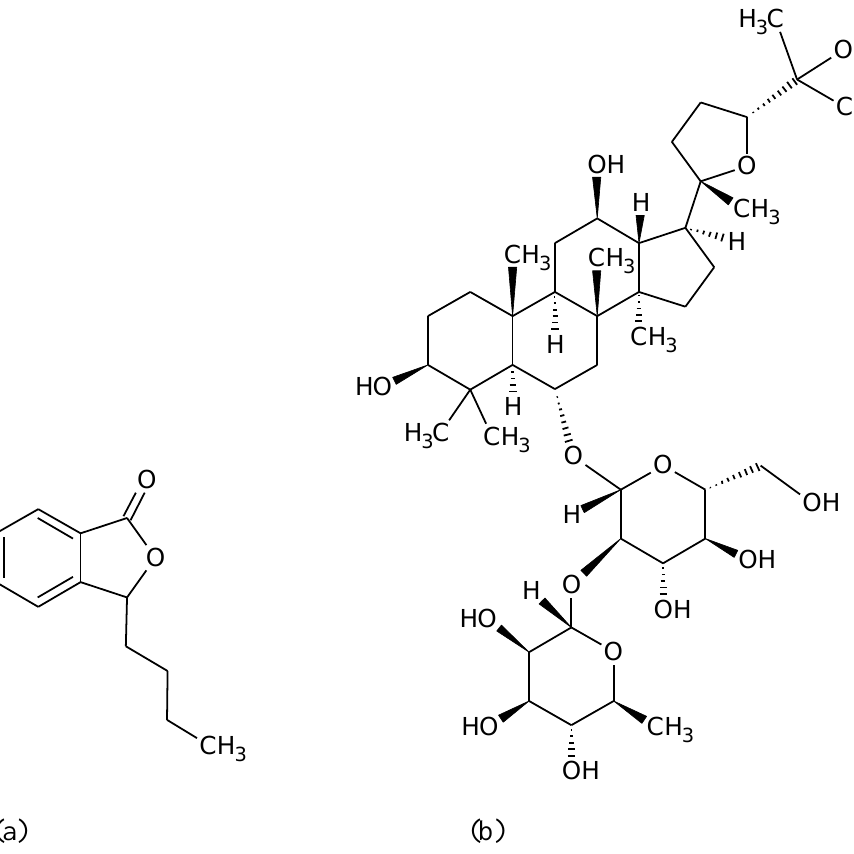
Figure 6. Chemical formula of ( a ) 3-n-butylphthalide and ( b ) pseudoginsenoside-F11.